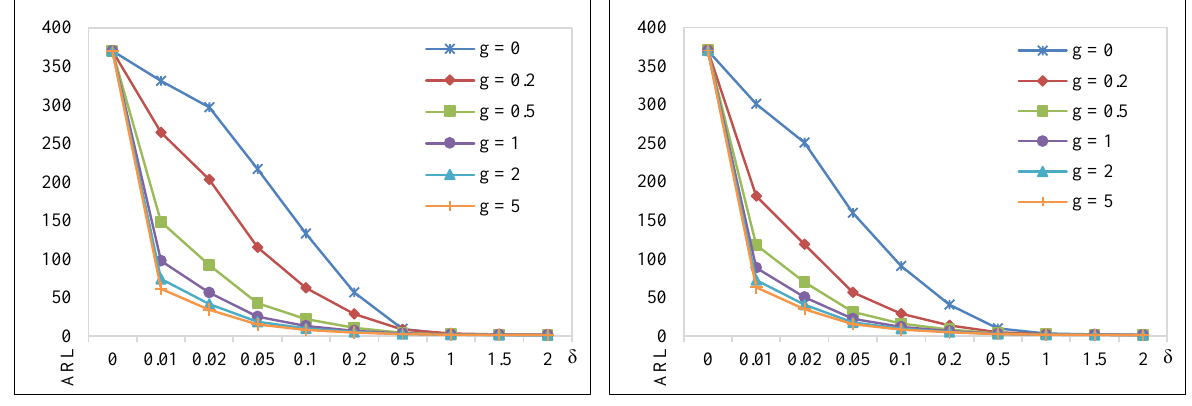
(f) The ARL for the price of WTI crude oil on the FIMA (1/2,2) model at λ = 0.20 Figure 3. The ARL of two datasets on the modified EWMA chart at various λ